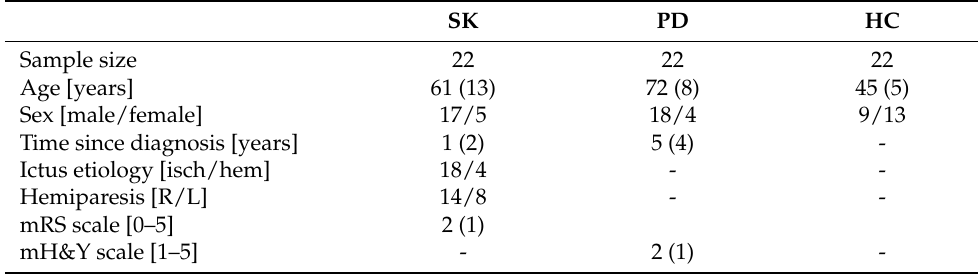
Table 1. The main characteristics of the participants.